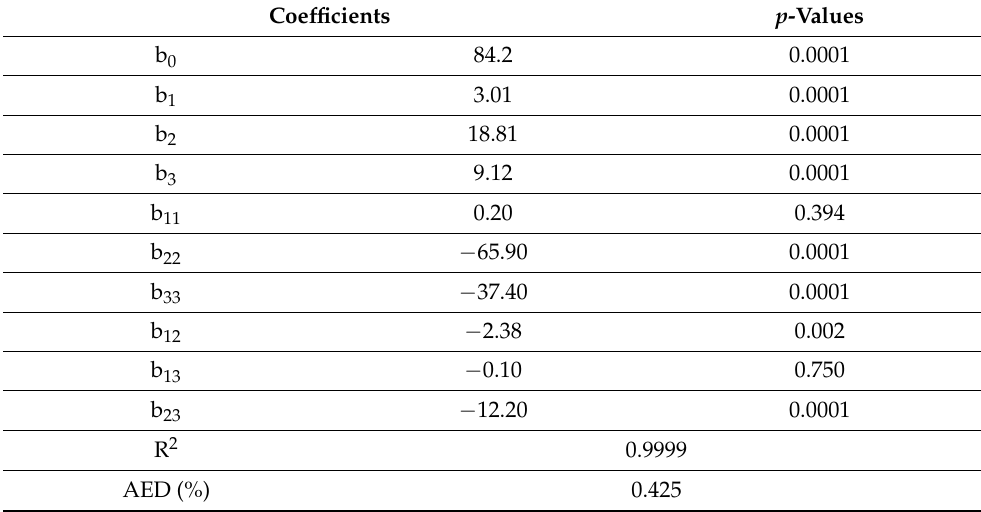
Table 6. Model constants, p -values, R 2 and AED